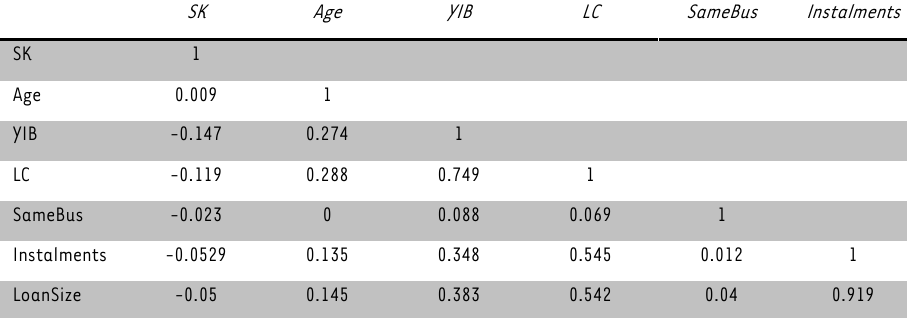
TABLE A2: Pearson’s correlation coefficient among SEF